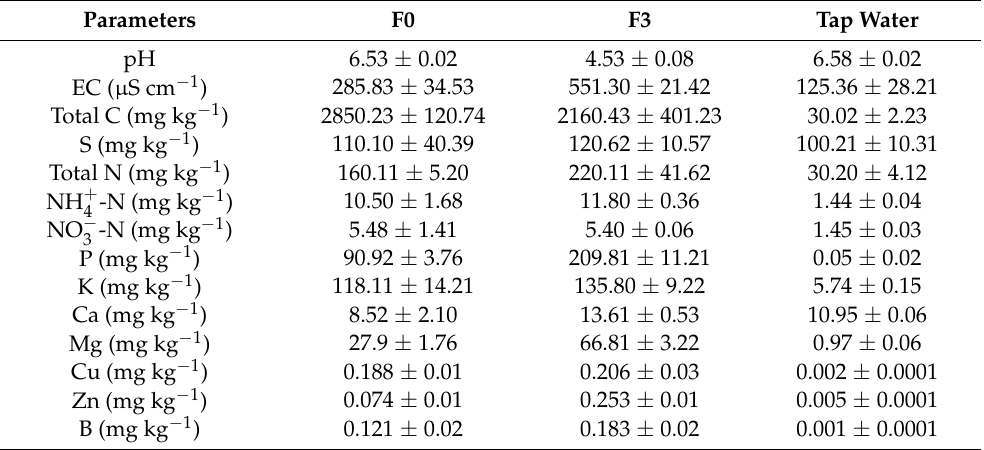
Table 1. Means ( ± SE) element analyses of washed rice water and the tap water used in the study. Parameters